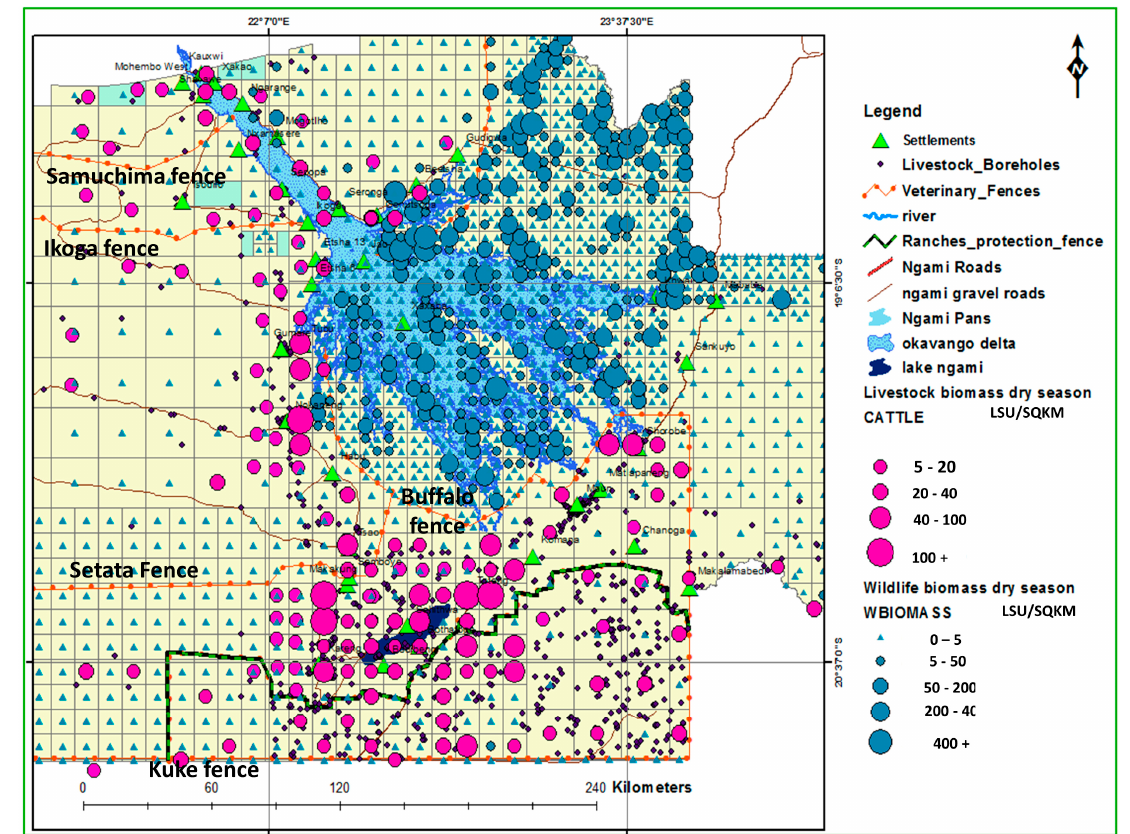
Figure 3. Dry season wildlife and livestock biomass in Ngamiland (based on wildlife aerial survey counts by the Department of Wildlife and National Parks)—livestock distribution pattern shows a high density in communal areas especially around water resources such as Lake Ngami.